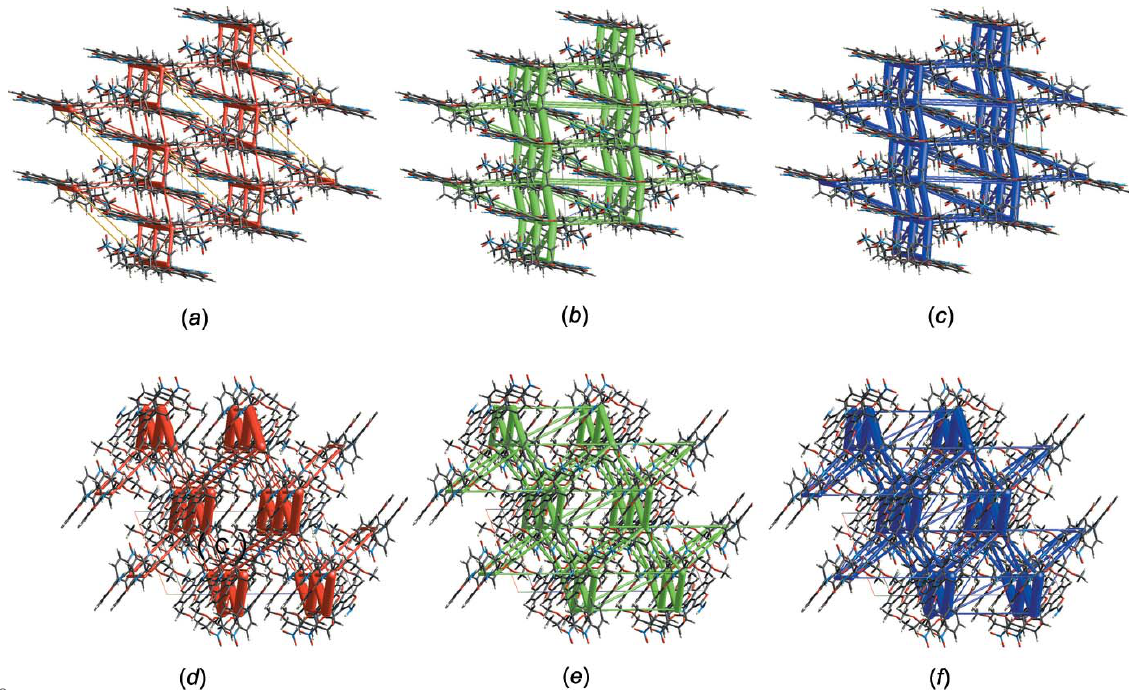
Figure 10 Framework interactions in BF1-molA ( a , b , c ) and in BF2 ( d , e , f ) with the electrostatic energy (red cylinders), dispersion energy (green cylinders) and total energy (blue cylinders). Yellow cylinders in ( a ) depict destabilizing positive interaction energies. Scale for tube/cylinder size is 80, cutoff of 8.00 kJ mol (cid:5) 1 used.